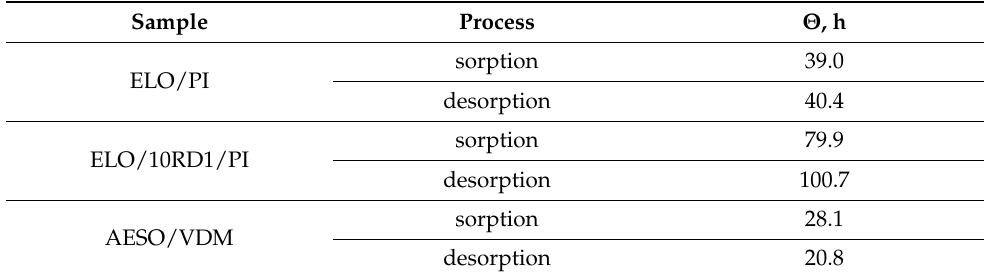
Table 1. The Parameters of the Exponential Curve Given by Equation 4 Fitted into the Experimental Data Presented in Figures 7 and 8. Sample Process Θ , h sorption ELO/PI